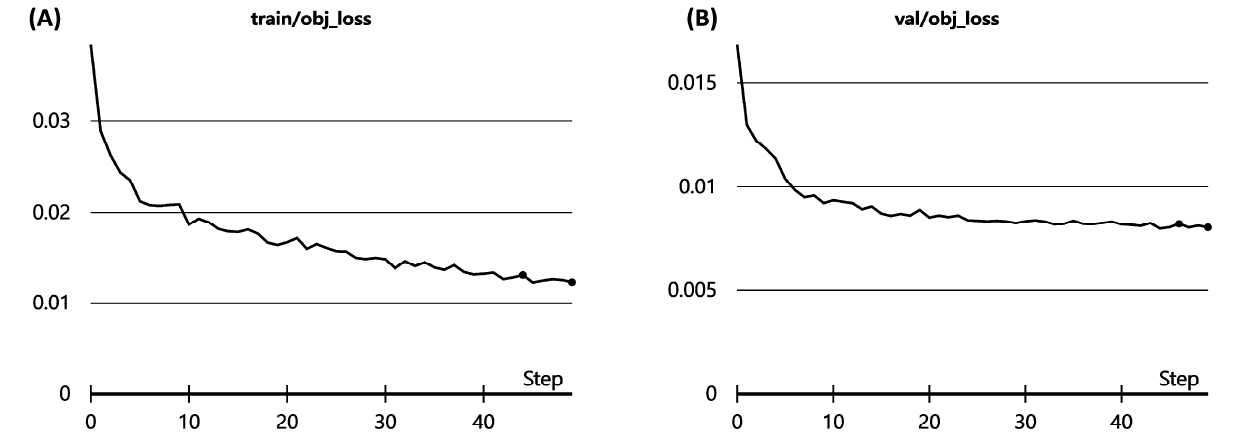
Figure 2. Train ( A ) & validation ( B ) losses of the Yolov5s model in the study. As the number of epochs increases, train losses always decrease. Validation losses decrease if the model is robust on new